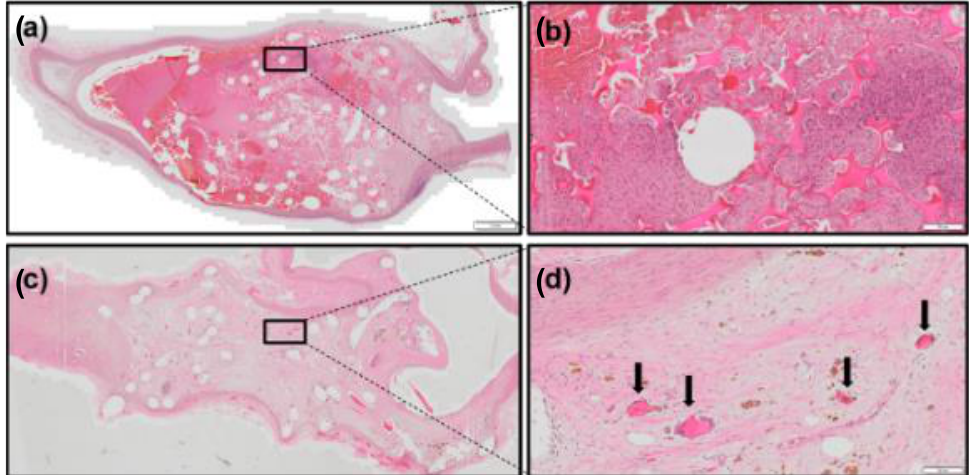
Figure 7. Thirty-day sections of NED devices in rabbit elastase-induced carotid aneurysms (1 μm) ( a ) present with numerous struts visible. These struts appear intact with only minor levels of surface degradation (100 μm) ( b ). Ninety-day sections show a rapid progression of degradation ( c ), with